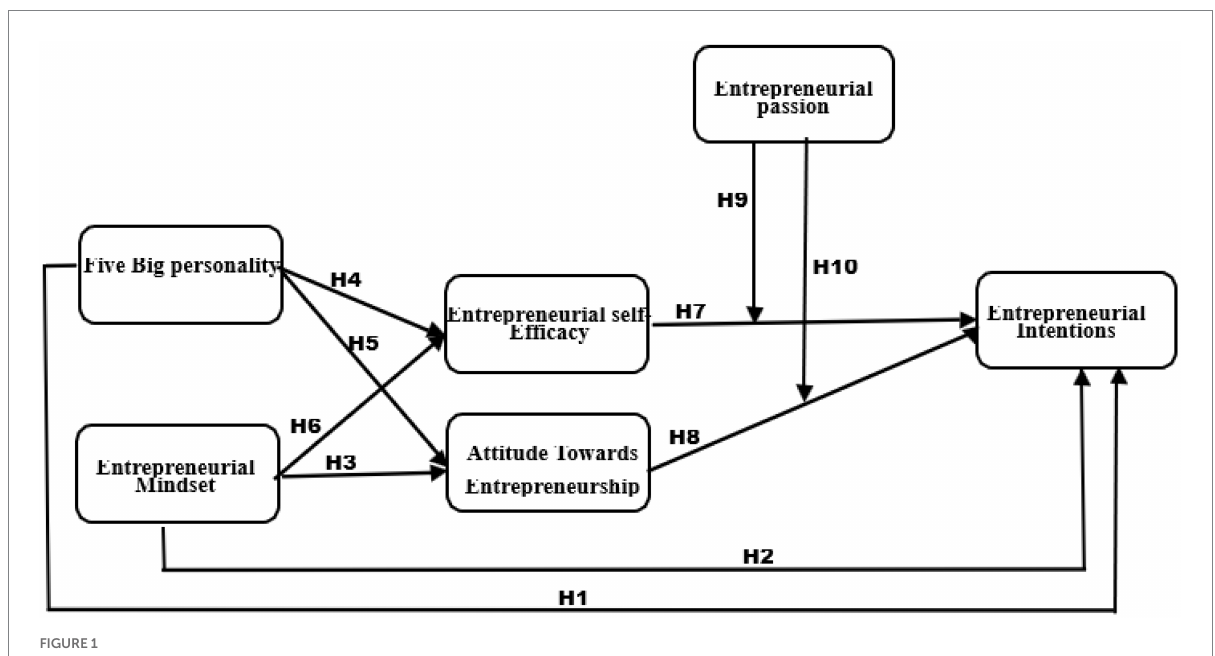
FIGURE 1 Conceptual framework of the